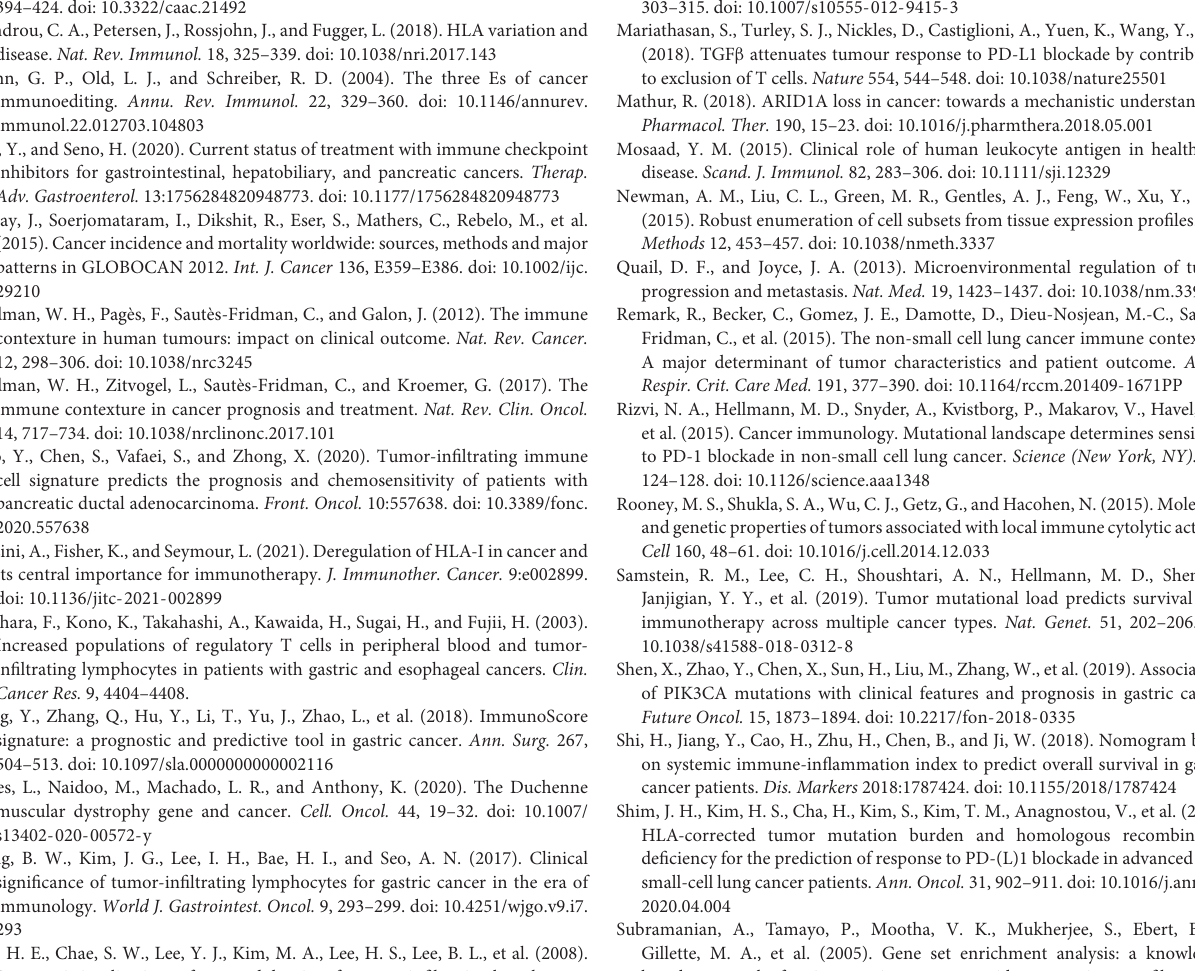
Supplementary Figure 2 | Estimation of the relative proportion of 28 types of immune cell subpopulations stratified by high- and low-risk signature groups in the